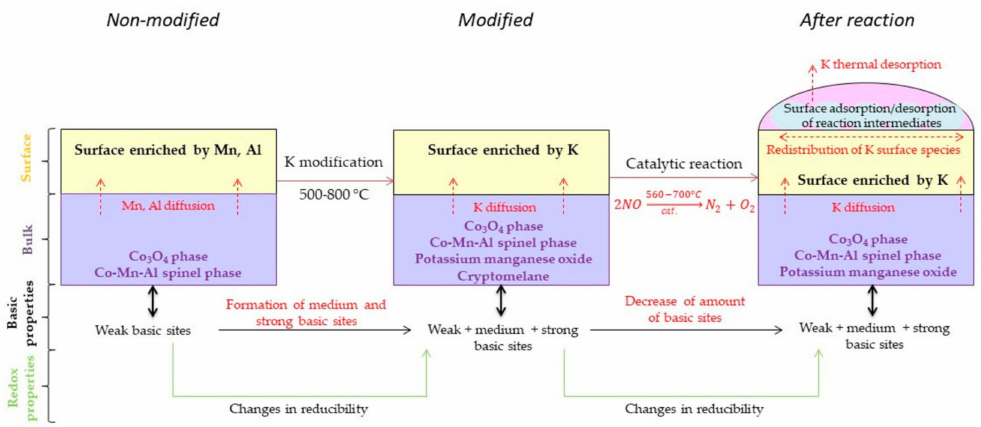
Figure 6. Mechanism of K promoting catalytic dissociation of NO over Co-Mn-Al catalyst [73]. Copyright 2019,